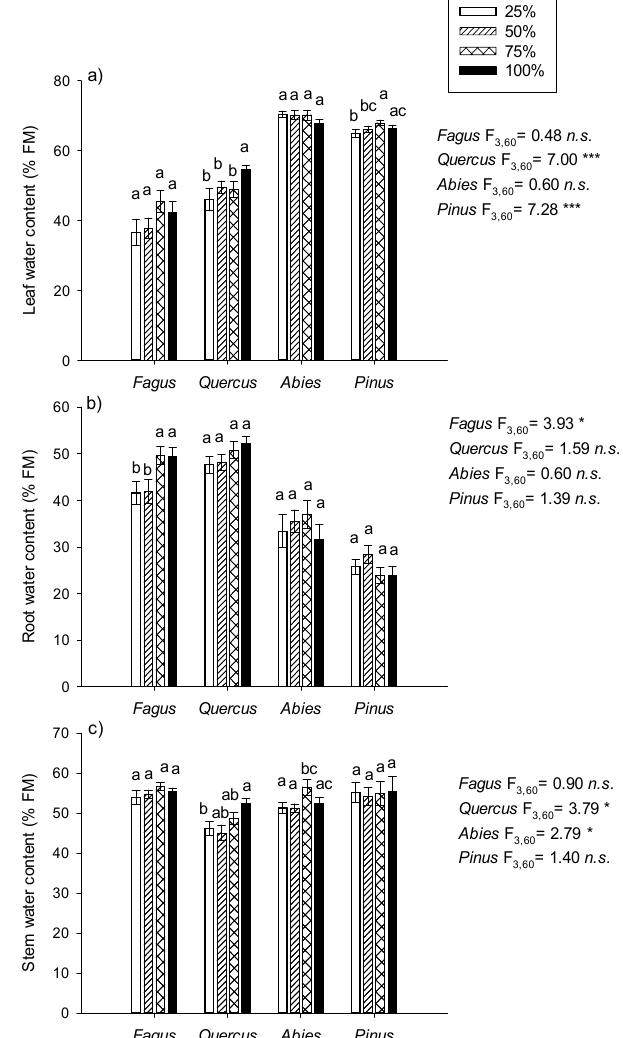
Figure 1. Water contents (determined as percentage of fresh mass) in leaves (LWC; ( a )), roots (RWC, ( b )) and stems (SWC; ( c )) of Fagus sylvatica , Quercus petraea , Abies alba , and Pinus sylvestris seedlings grown at di ff erent irrigation treatments (100%, 75%, 50%, and 25% of the recommended dose). Bars indicate means ± SE ( n = 16). One-way analysis of variance F -values for treatment e ff ect within species and the associated p values are shown *** p < 0.001, ** p < 0.01, * p < 0.05 , n.s. —not significant). Means marked by the same letters (a, b c) within species were not significantly different.